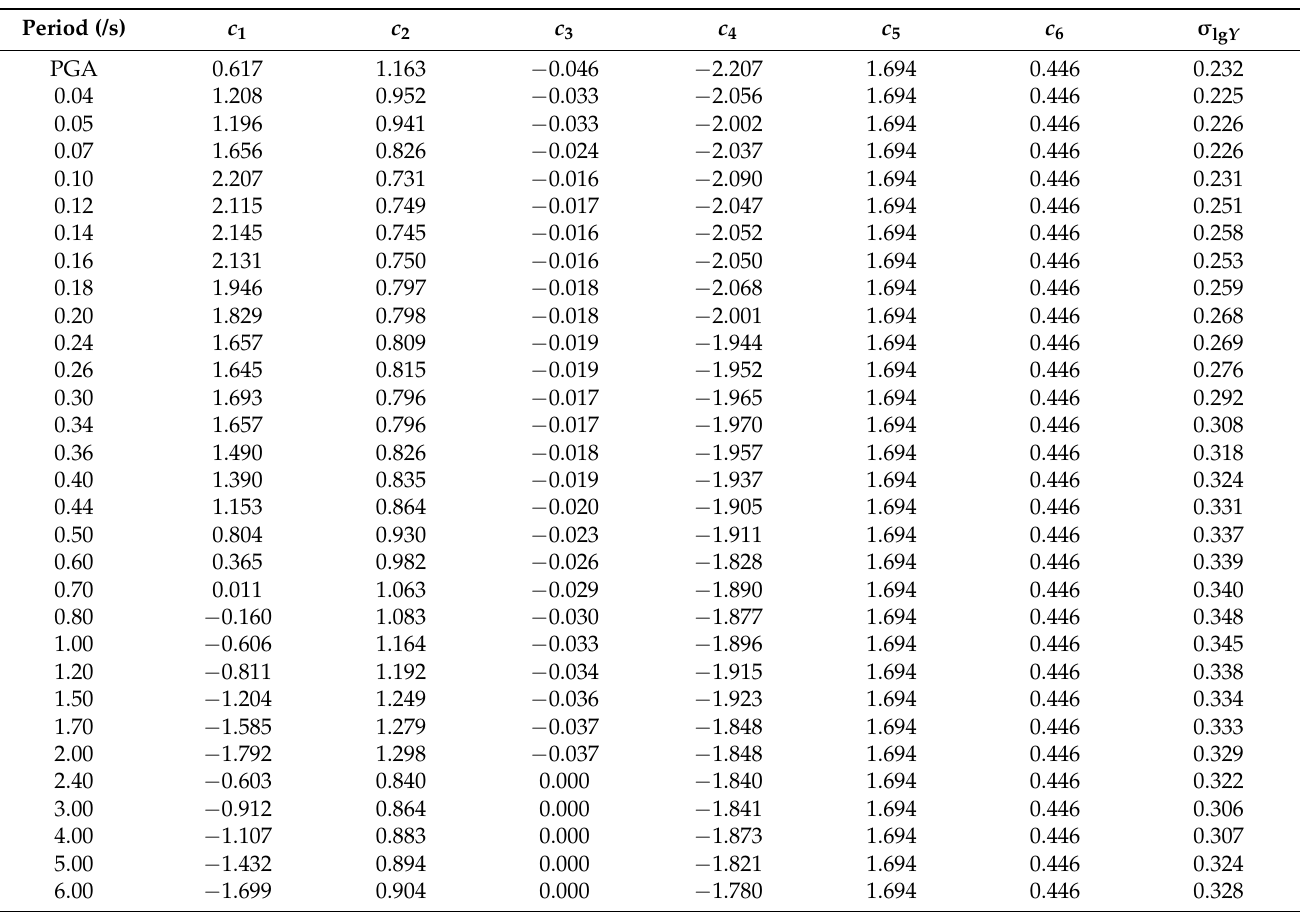
Table 4. Relational coefficient of bedrock ground motion attenuation (major